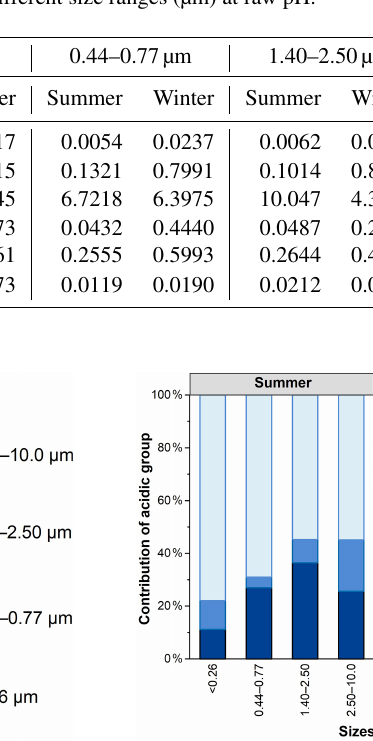
Table 1. The optical properties of WSOC in particles of different size ranges (µm) at raw pH.